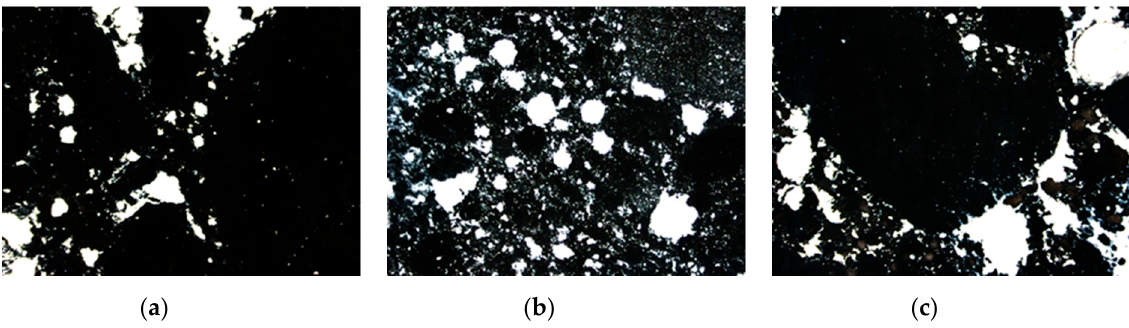
Figure 7. The image of the microstructure of air voids in the analysed concrete specimens: ( a ) PW5, ( b ) PW8, and ( c ) PW9 (air voids marked with white). The air void spacing meets the requirements.